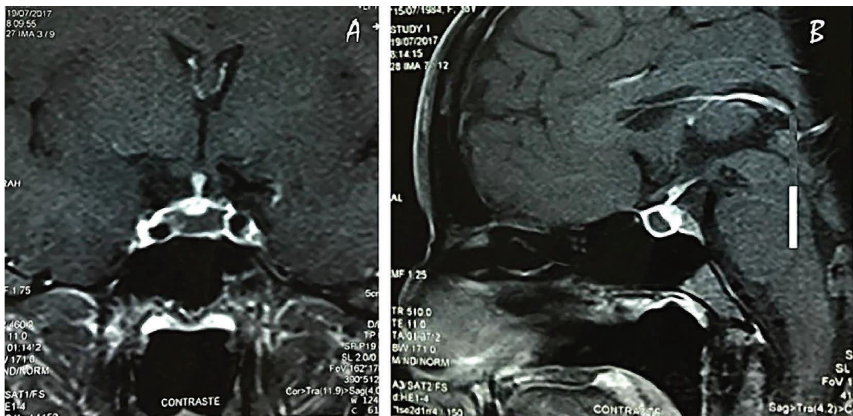
Figure 1: Coronal (a) and sagittal (b) postcontrast MRI at diagnosis. It shows an enlarged pituitary gland with suprasellar extension, peripheral enhancement of the pituitary gland, and irregular and poorly enhanced central portion after gadolinium